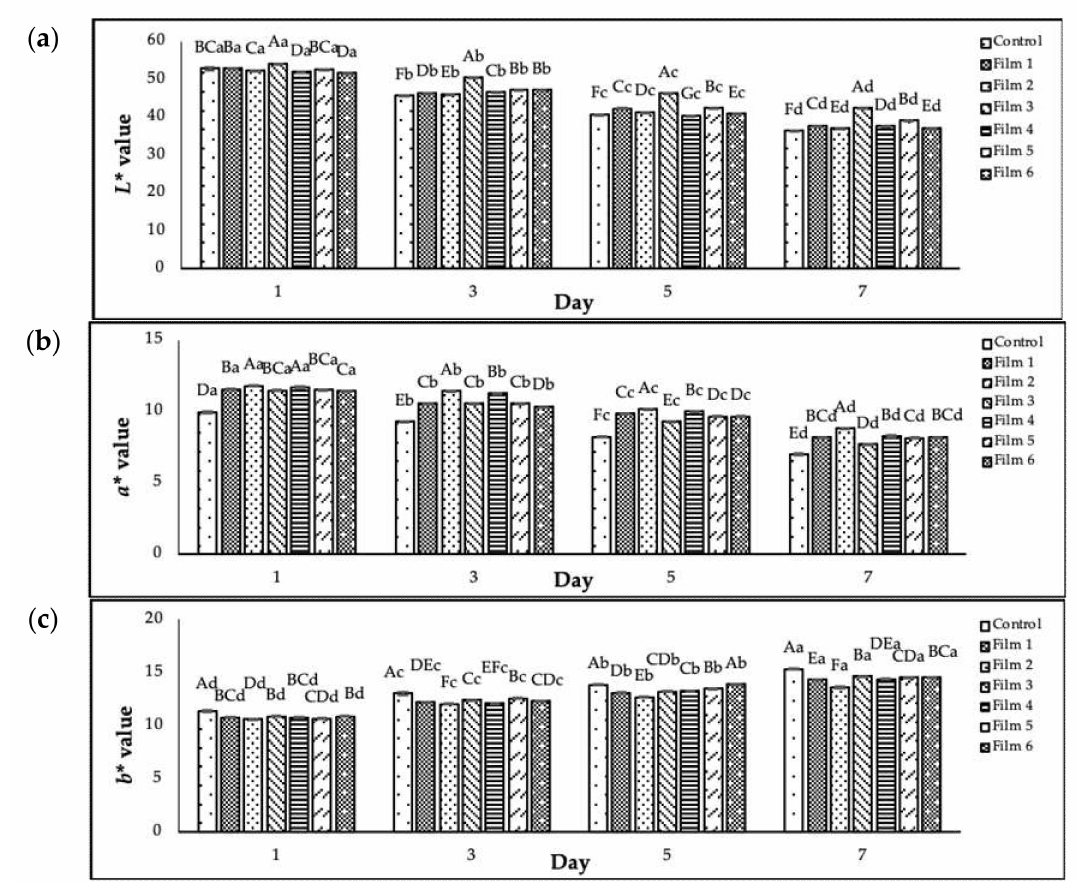
Figure 4. ( a ) The values of L *, ( b ) the values of a *, and ( c ) the values of b * for chicken meat stored in a PP container and plastic film laminated trays during seven storage days at 4 ◦ C. Colour parameters: L *, a *, and b *. Control: polypropylene (PP) microwavable container. Error bars indicate the standard deviation ( n = 3). Capital letters of A – F are different significantly ( p < 0.05) for each day amongst the treatments. Small letters of a – d are different significantly ( p < 0.05) for each sample amongst the storage